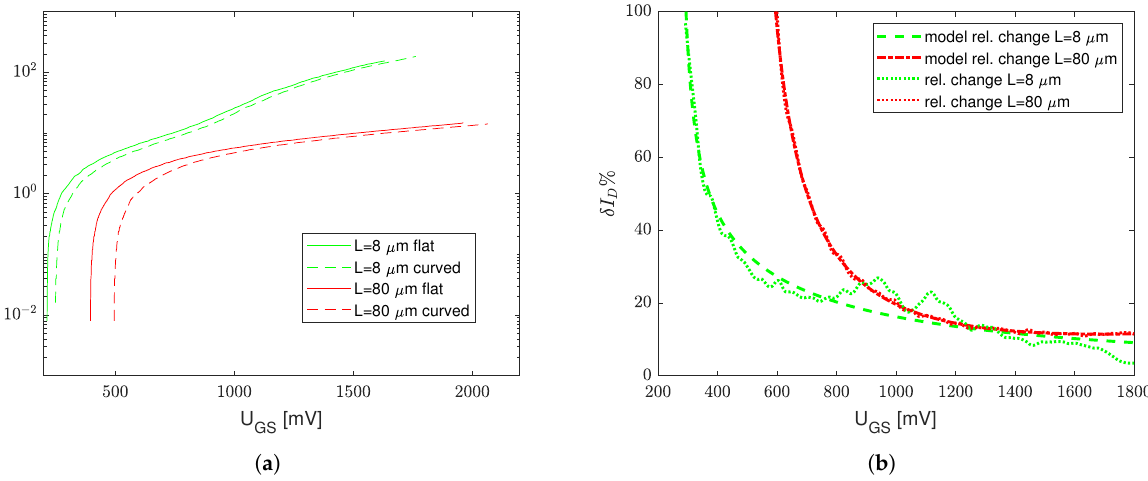
Figure 4. Transfer characteristics of stressed (compressive strain (cid:15) = 0.2%) and unstressed transistors with minimum channel width ( a ) and their relative difference ( b ) at various U GS